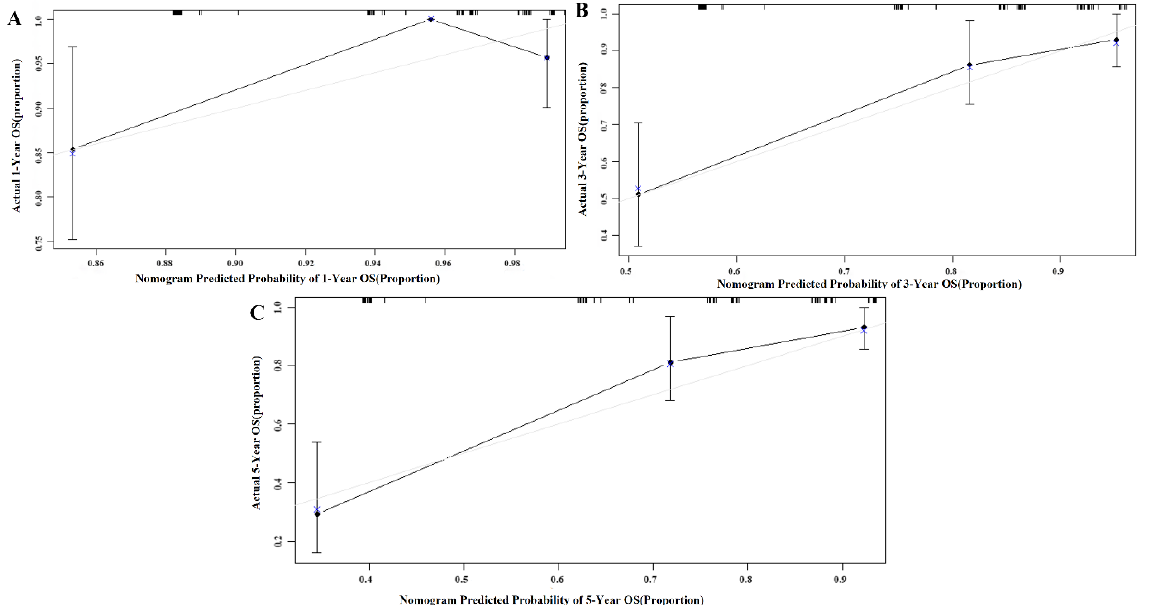
Figure 2. Calibration curve of the nomogram in the primary cohort, with the x -axis representing the actual survival estimated by the nomogram and the y -axis representing the observed survival calculated by the Kaplan–Meier method. ( A ) 1-year OS in the primary cohort. ( B ) 3-year survival OS in the primary cohort. ( C ) 5-year survival OS in the primary cohort.